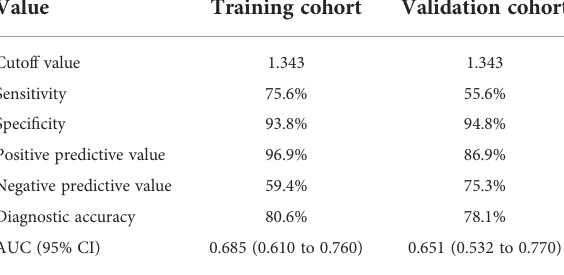
TABLE 4 Performance of the prediction Nomo-score for estimating the risk of BRAF mutation.